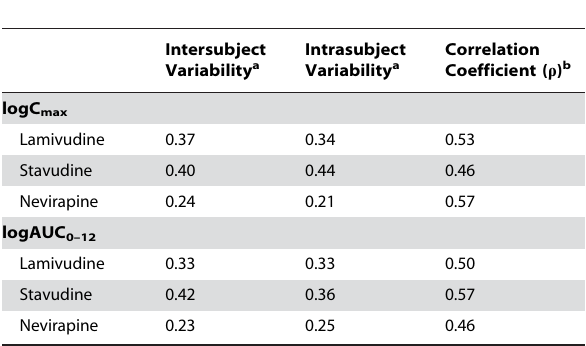
Table 4. Inter- and intrasubject variability in log transformed pharmacokinetic